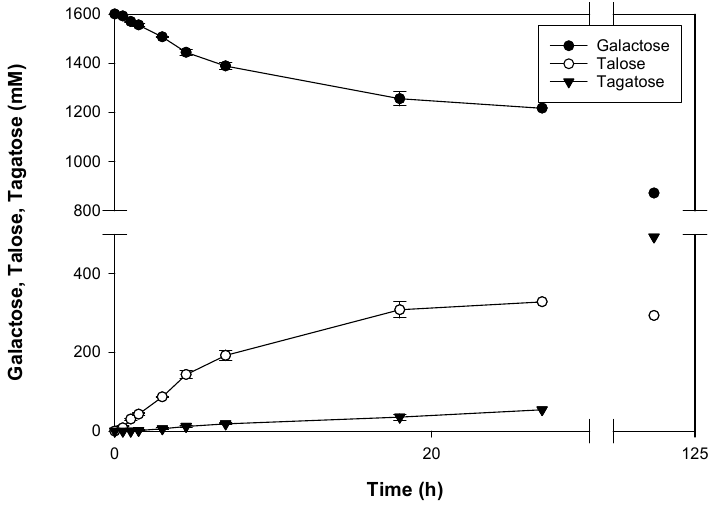
Figure 1. Galactose to talose conversion by Rm CE also generates the isomerization product tagatose.